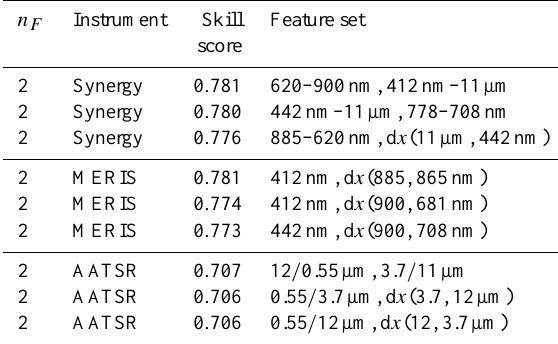
Figure 6. Similar to Fig. 5 but for a different classical Bayesian cloud mask based on four strongly independent features. The global skill score is 0 . 83. Table 1. Best found results for feature sets of classical Bayesian cloud masks with two strongly independent features which best recreate Synergy cloud mask results. The results are separated for the Synergy of MERIS and AATSR, MERIS, and AATSR. Chan- nels are referenced by their central wavelength. MERIS channels use the unit nm, while AATSR channels use